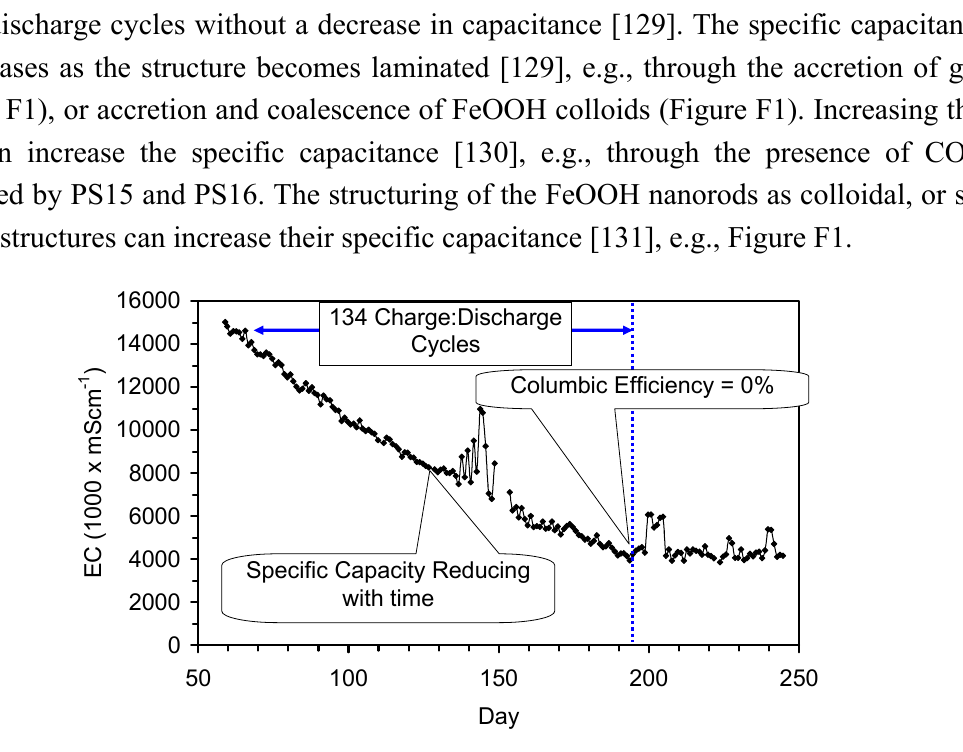
Figure F2. Impact of progressively reducing water salinity on the rate of desalination with time. ZVM TP Trial ST1a: Extracted from Figure